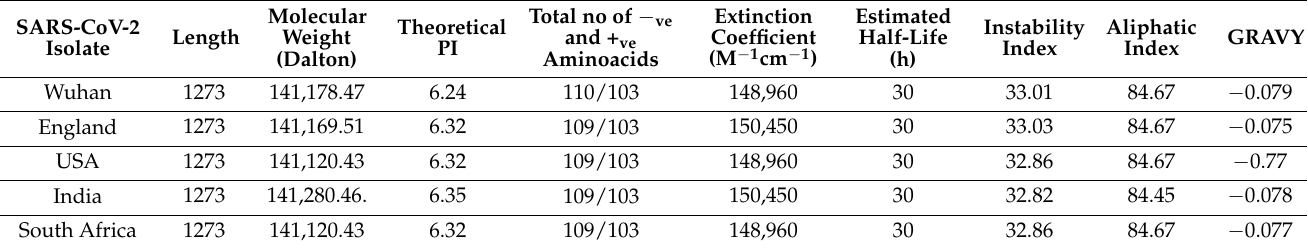
Table 1. Physico-chemical parameters of SARS-CoV-2 isolates